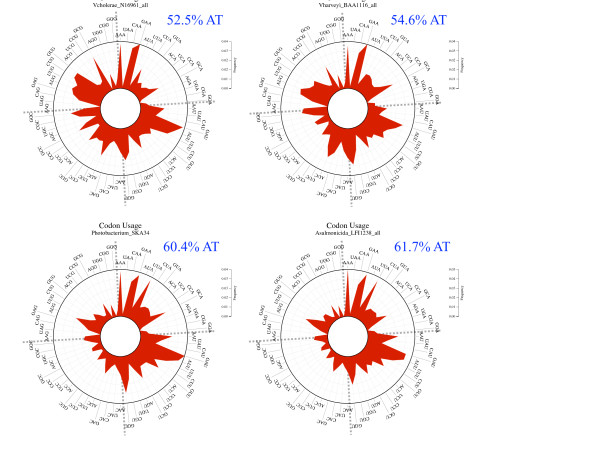
Codon usage rose plots for four representatives of different vibrio genera. The vibrios with a higher AT content (bottom rose plots) have a codon usage bias of A or U at the third position of the codon. The frequency scale is represented at the right side of the rose plots.